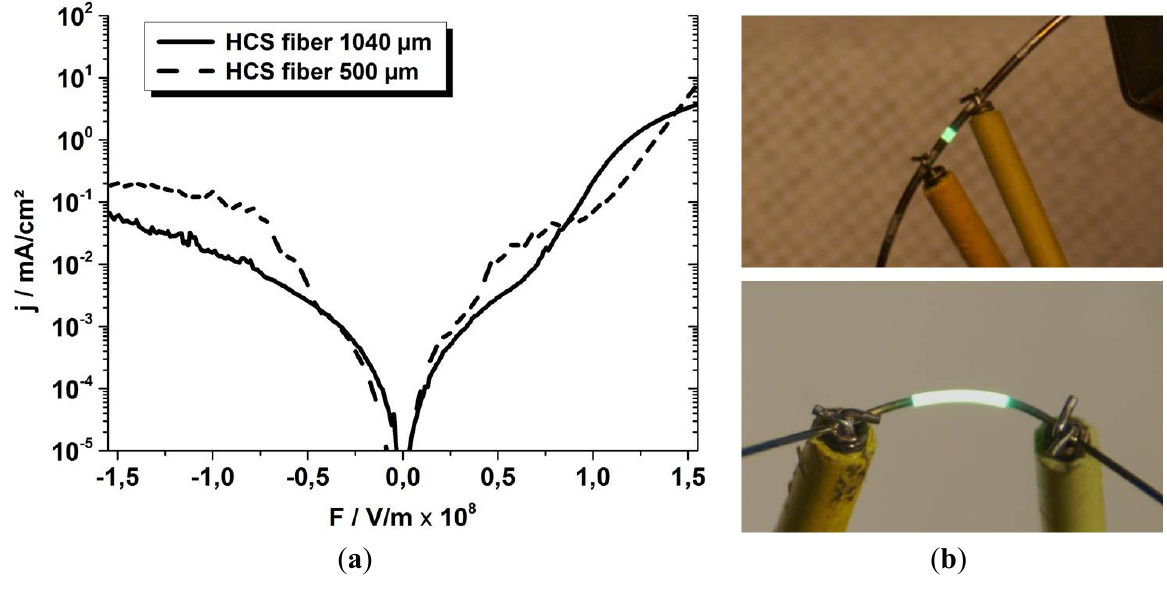
Figure 6. ( a ) j - F -characteristics and ( b ) photographs of a 1 mm OLED produced on a 1040 μm thick ETFE-coated, thermally smoothed HCS fiber ( top ) and a 5 mm OLED produced on a 500 μm thick HCS fiber treated the same way ( bottom